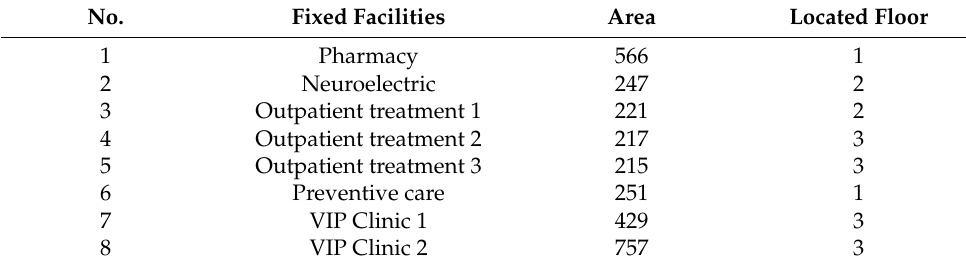
Table 5. Fixed facilities information.